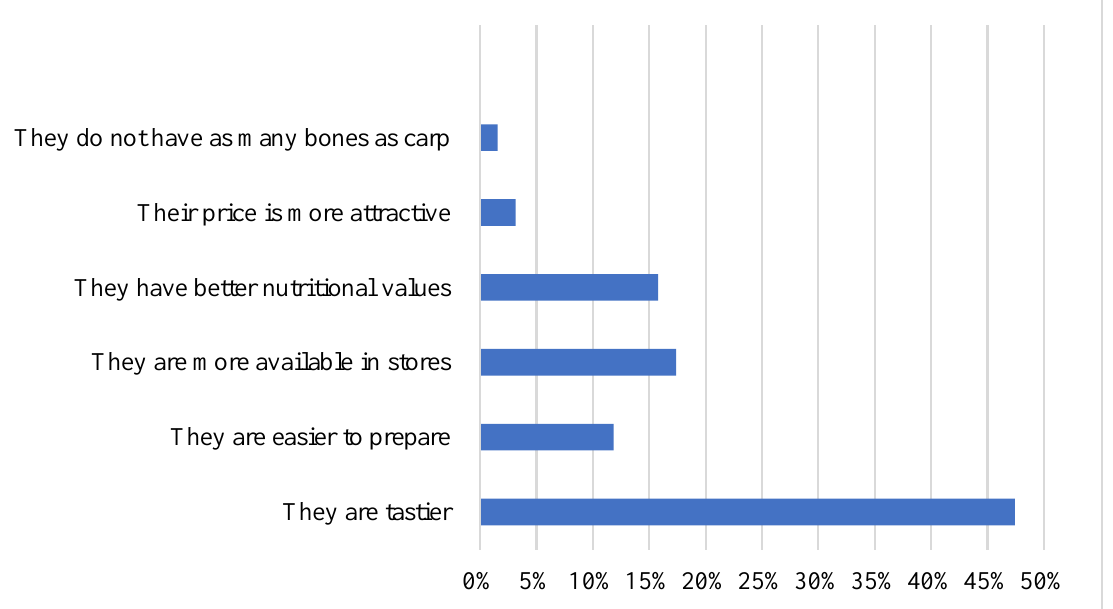
Figure 7. Preferences for sea fish among the Young Adult Populations in relation to carp. Source: own elaboration based on data of [43].